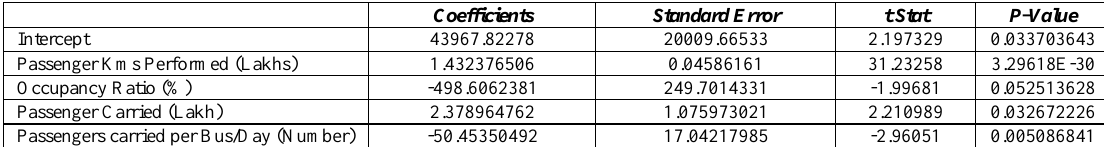
Table 9. Regression analysis for passenger